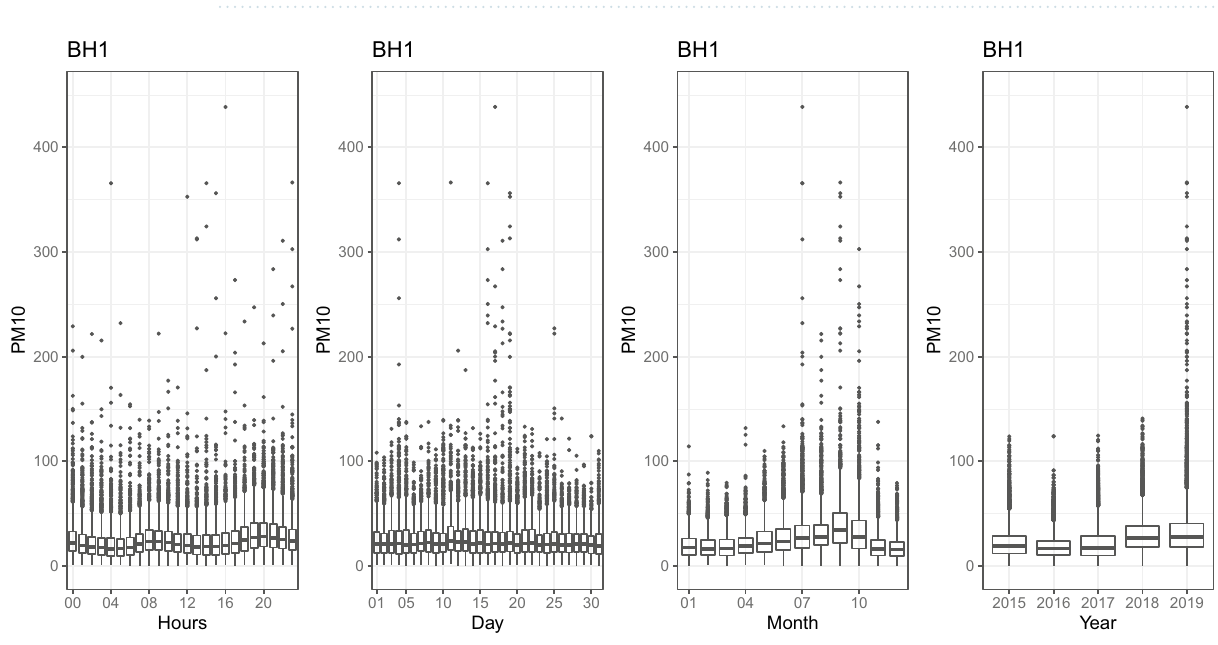
Figure 3. Hourly, daily, monthly and yearly boxplots for the monitoring station located in the Brazilian state capital of Minas Gerais, Belo Horizonte (BH1),